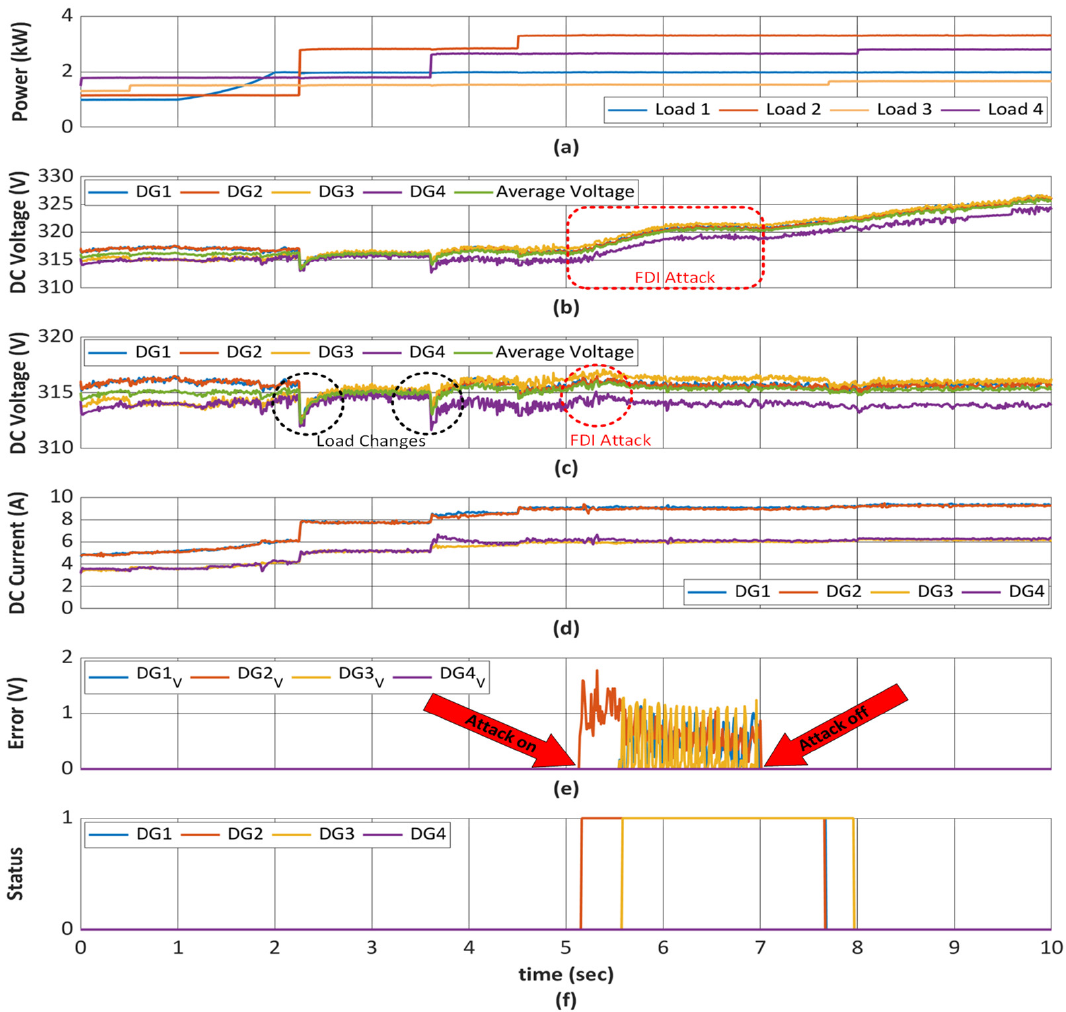
Figure 6. System performance in the presence of hijacking attack in voltage sensor: ( a ) Load profiles. ( b ) Output DC voltages of a standard secondary controller. ( c ) Output DC voltages with proposed method. ( d ) Output current with proposed method. ( e ) Error signals. ( f ) Final status of DGs in attack